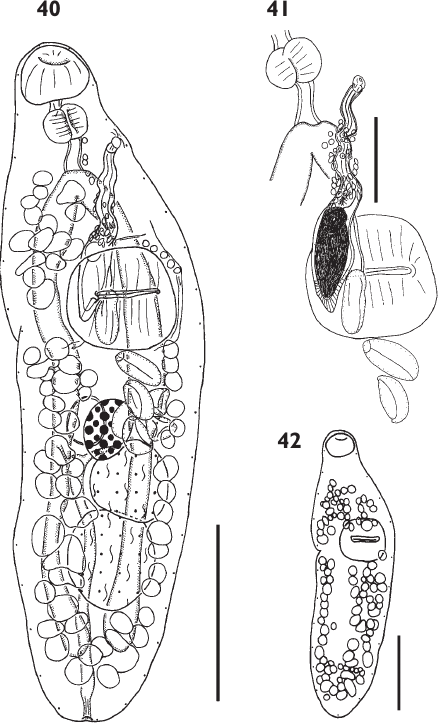
Figs 40-42. Macvicaria kingscotensis n. sp. ex Haletta semifasciata . 40. Whole-mount ventral view. 41. Termi- nal genitalia. 42. Dorsal distribution of vitelline follicles. Scale bars : 40, 42, 250 μm; 41, 100